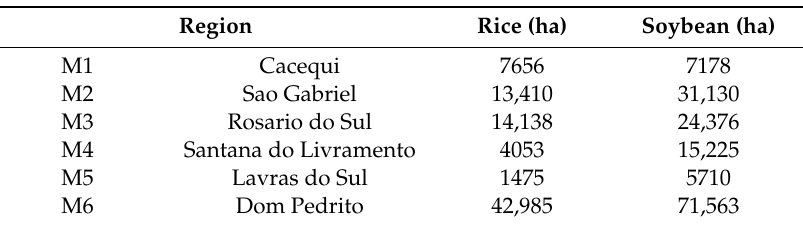
Table 1. Rice and Soybean